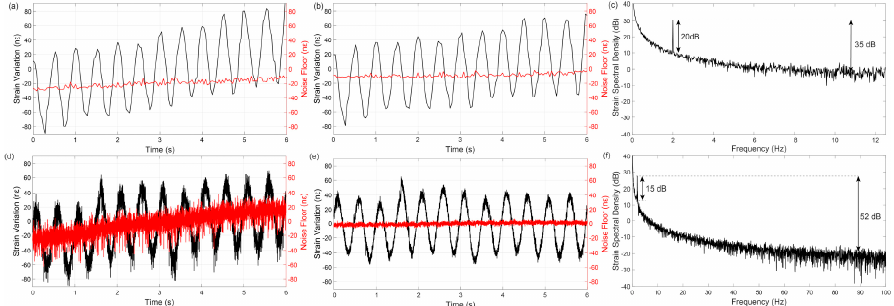
Figure 19. Strain signal at the piezoelectric fibre section (black), placed at the end of the fibre (50 km—point of lowest SNR), applying a 2 Hz sinusoidal strain signal with 80 n ε peak-to-peak. In red, a neighboring channel (placed at 49 km), showing the measurement noise floor for comparison. Strain measured with configurations of Figure 18b ( a – c ) and Figure 18c ( d – f ) is presented; The time-domain of the strain signal is shown before ( a , d ) and after ( b , e ) laser noise compensation; ( c , f ) Strain PSD for the applied perturbation.